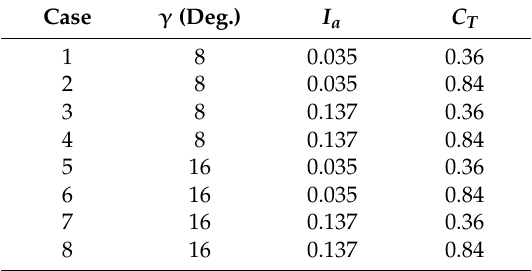
Table 2. Parameters of numerical